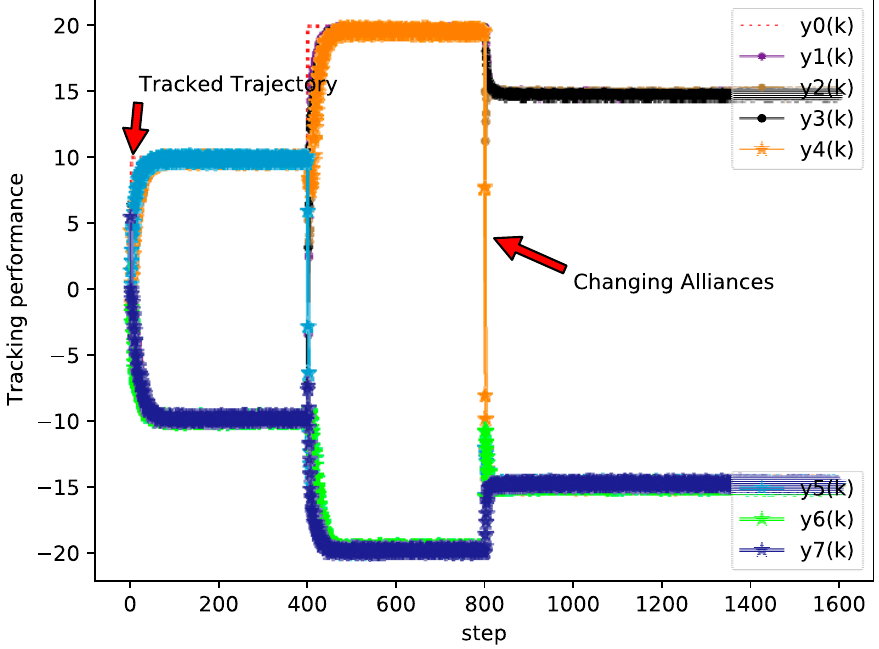
Figure 12. Tracking errors of each agent (example 3).